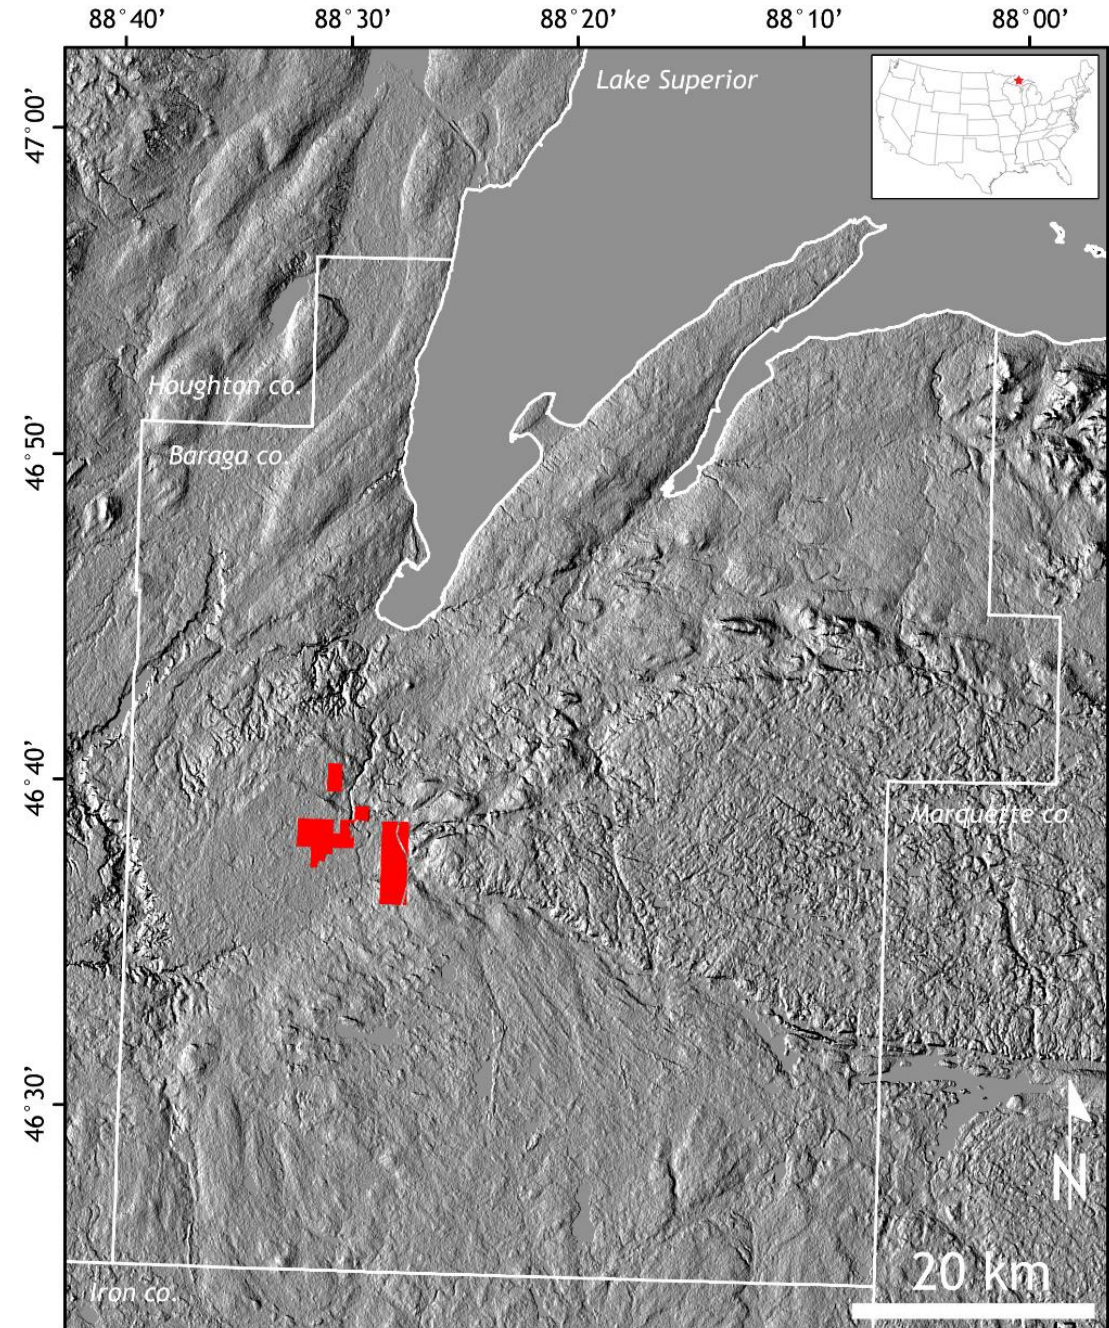
Figure 1. SRTM-derived hillshade visualization of Baraga County, Michigan (USA), and location of the FFC management units